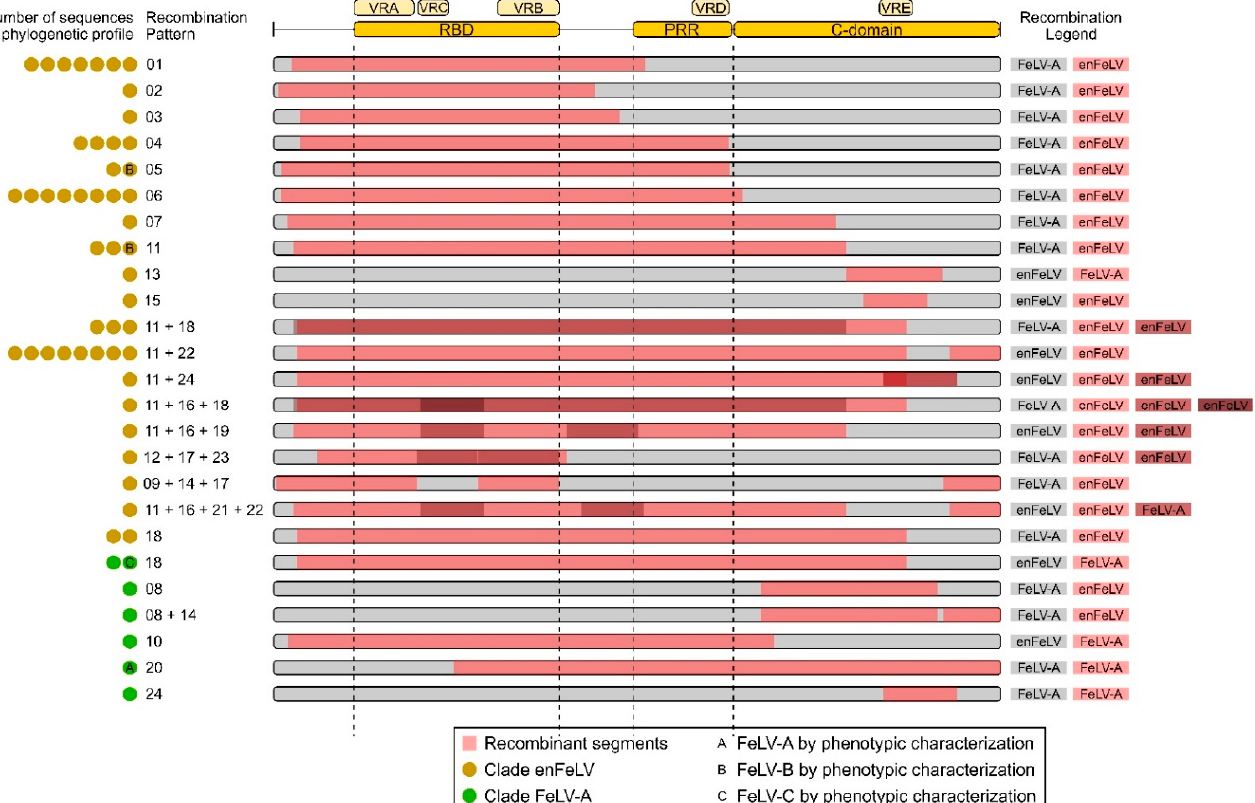
Figure 1. Scheme of the recombinant patterns obtained in RPD4. The number of sequences representing each recombinant pattern is indicated by colored circles. Sequences belonging to clade enFeLV are indicated in yellow and sequences belonging to clade FeLV-A in green. The recombination segments are shown for each pattern. Colored circles with letters A, B or C represent FeLV-A, FeLV-B or FeLV-C sequences identified by phenotypic characterization. RBD: receptor binding site, PRR: proline-rich region, VRA, VRC, VRB, VRD, VRE: variable region A, C, B, D and E respectively.